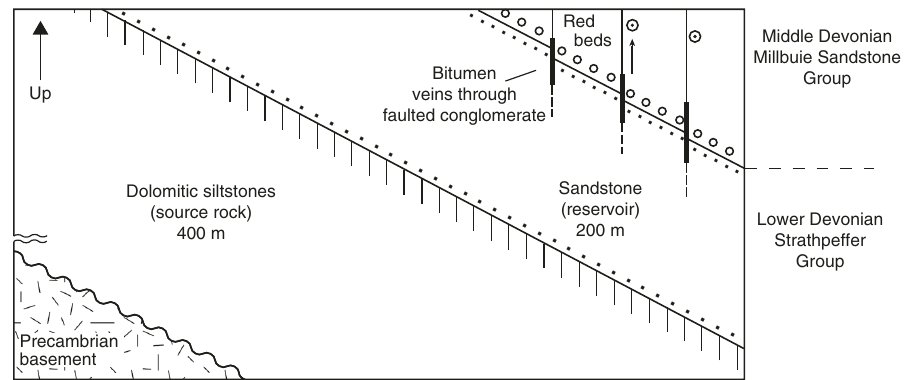
Fig. 2 Schematic view of geological context of Dingwall samples. Key to symbols: stipples = igneous basement; parallel lines = mudrock; dots = sandstone; open circles = conglomerate; bulls ’ eyes = reduction spheroids. Bitumen is present at the cores of the reduction spheroids and in the local fractures. Adapted from ref. 24